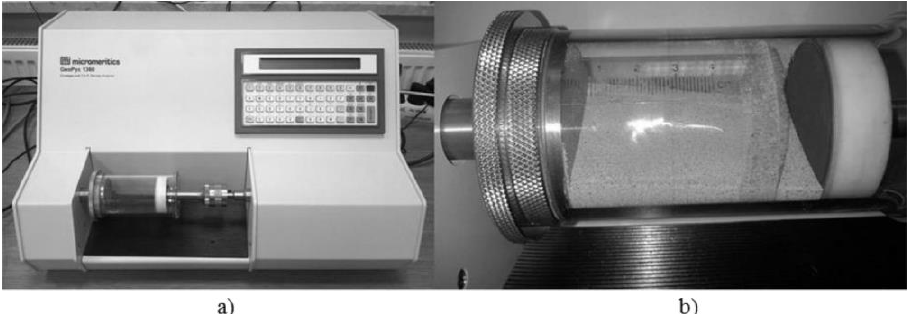
Figure 6. GeoPyc 1360 pycnometer: ( a ) general view and ( b ) measuring chamber.